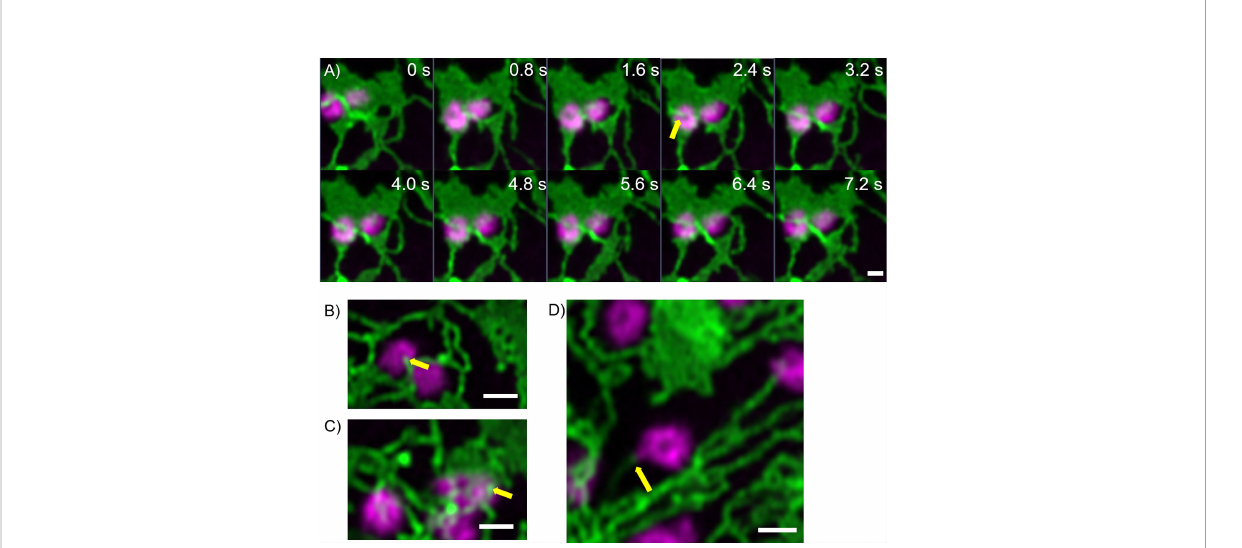
FIGURE 3 Uniquely shaped ER tubules connect with Golgi bodies. Fine ER tubules thread through ( A, B yellow arrows) and around the Golgi bodies ( C yellow arrow) and can connect with Golgi protrusions ( D , yellow arrow). Golgi bodies are labelled with the medial/ trans -Golgi marker ST- mRFP (in magenta) and the ER is labelled with GFP-HDEL in green. Markers are expressed transiently in tobacco leaf epidermal cells. Images for A ) are shown in time intervals of 0.8 s between the frames and time points are indicated. Size bars = 1